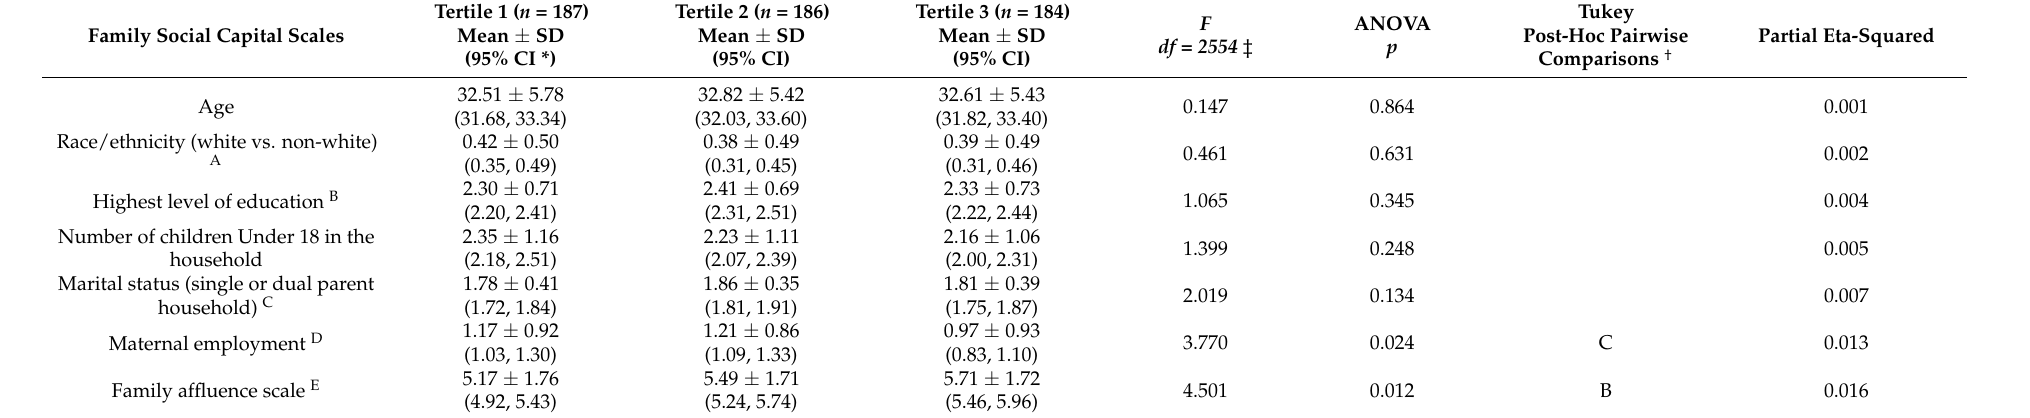
Table 2. Maternal sociodemographic characteristic comparisons by family social capital tertiles ( n =